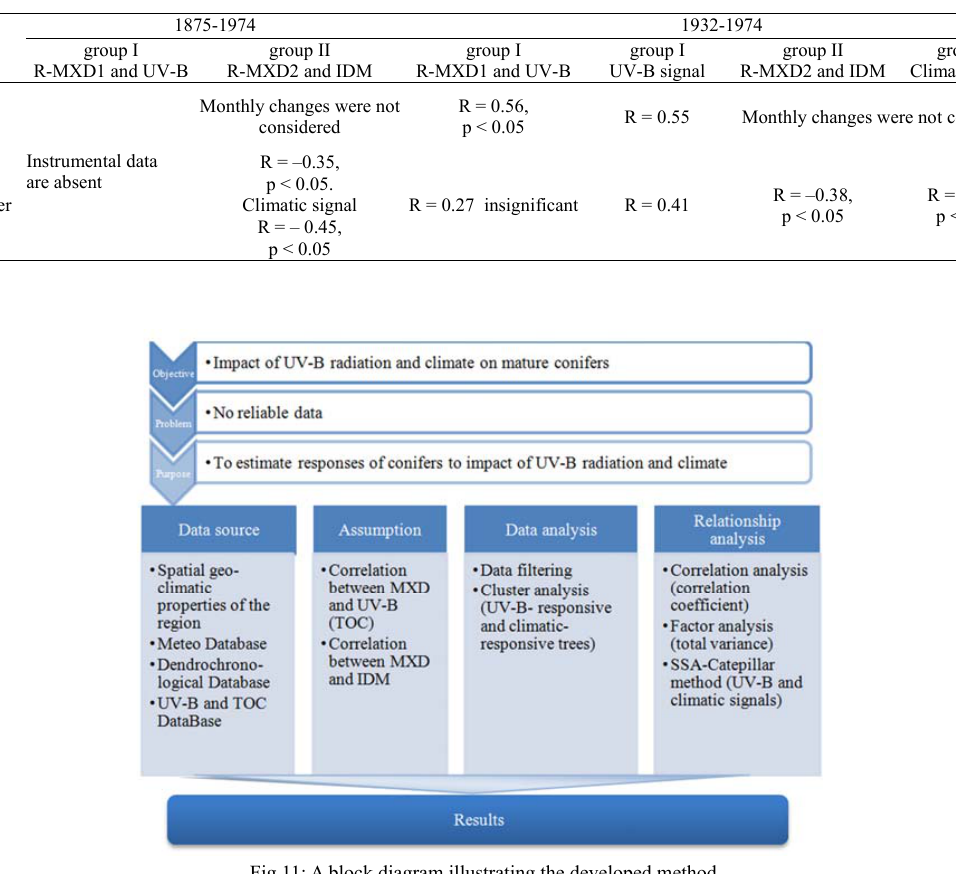
Table 3 : Effect of UV-B and climate on regional tree ring density in the Swiss Alps Table 3: Effect of UV-B and climate on regional tree ring density in the Swiss Alps